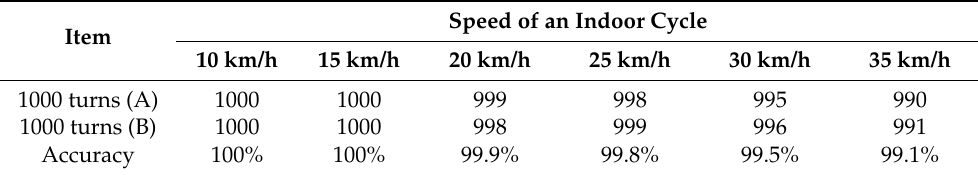
Table 5. Experiment result for calculating the exercise speed of a treadmill.